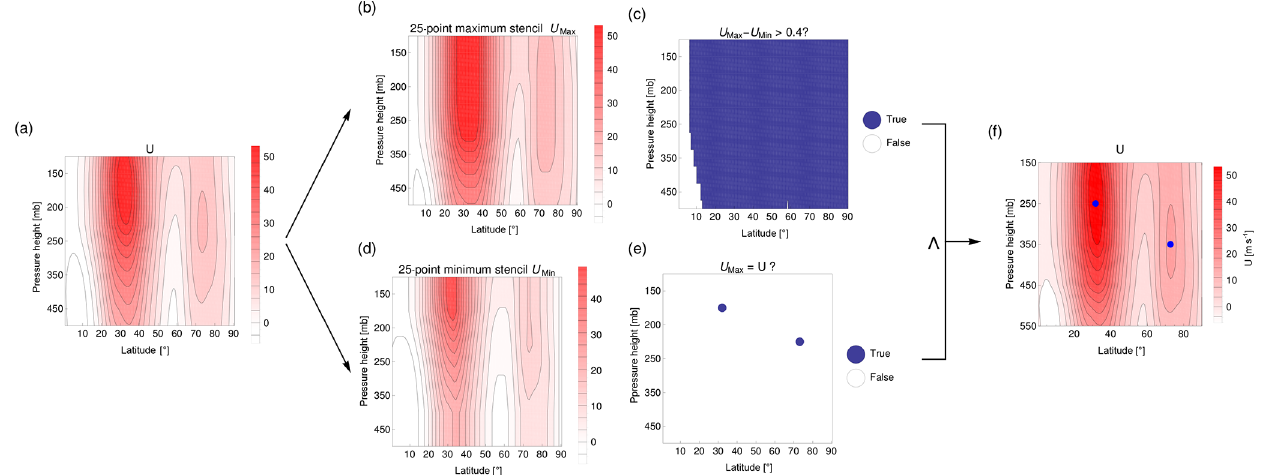
Figure 3. Rikus’ scheme. In (b) the 25-point maximum stencil ( U Max ) is calculated from (a) and in (d) the 25-point minimum stencil ( U Min ) is calculated from (a) . In (d) the condition U Max ( x , y ) − U Min ( x , y ) > 04 is examined and in (e) the condition U Max ( xy ) = U ( xy ). Only those points, where both conditions are fulfilled are zonal-mean jet stream cores, the blue points in ( f )